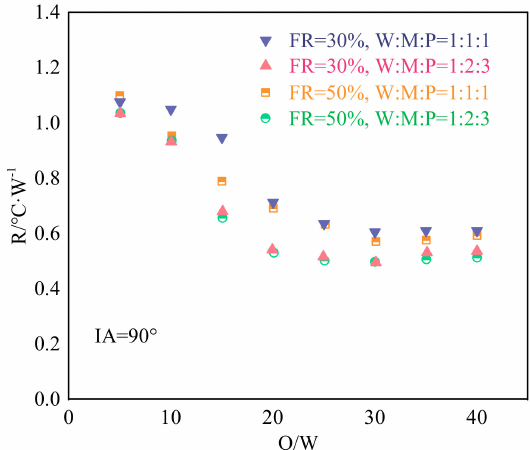
Figure 8. Change in thermal resistance with heat load for each mixture under different mixing ratios [149]. Markal et al., (2021).